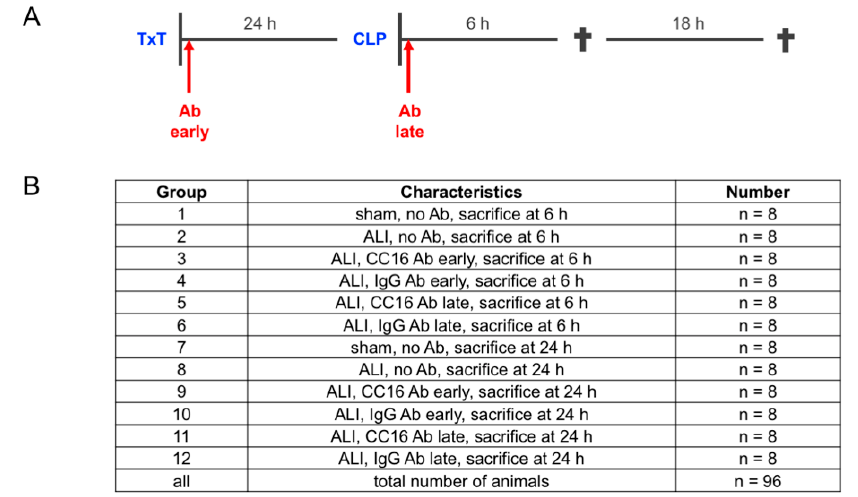
Figure 1. ( A ) Experimental design. Mice underwent the double hit consisting of thoracic trauma (TxT) and cecal ligation and puncture (CLP). The sham control group underwent identical surgical procedures and anesthesia, as described above, without performing TxT or CLP. Interventions with either CC16 antibody (Ab) or IgG control (IgG) antibody were performed either early (post TxT) or late (post-CLP) to the lungs. Six or 24 h later animals were euthanized for sampling. ( B ) Group allocation and group size is given.